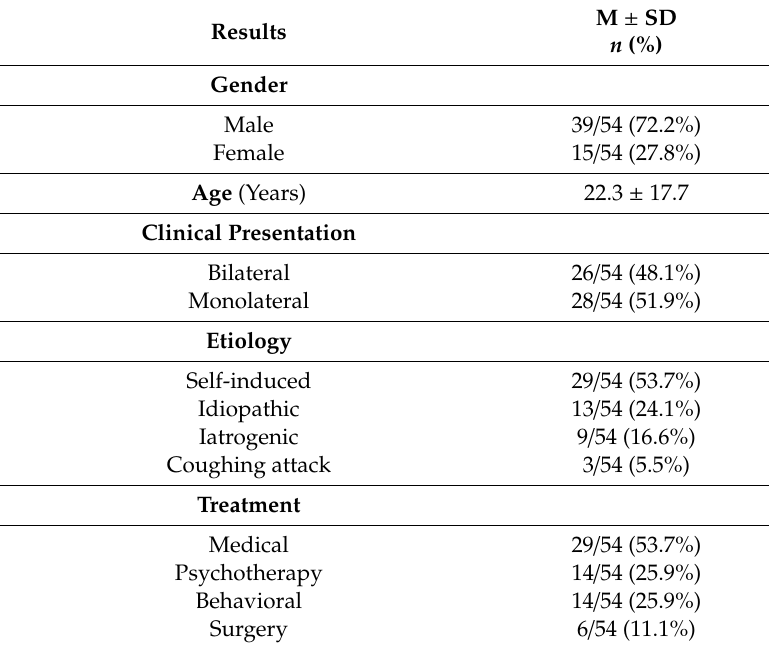
Table 2. Summary of